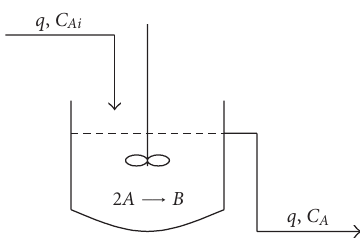
Figure 3: A schematic diagram of a stirred tank reactor.